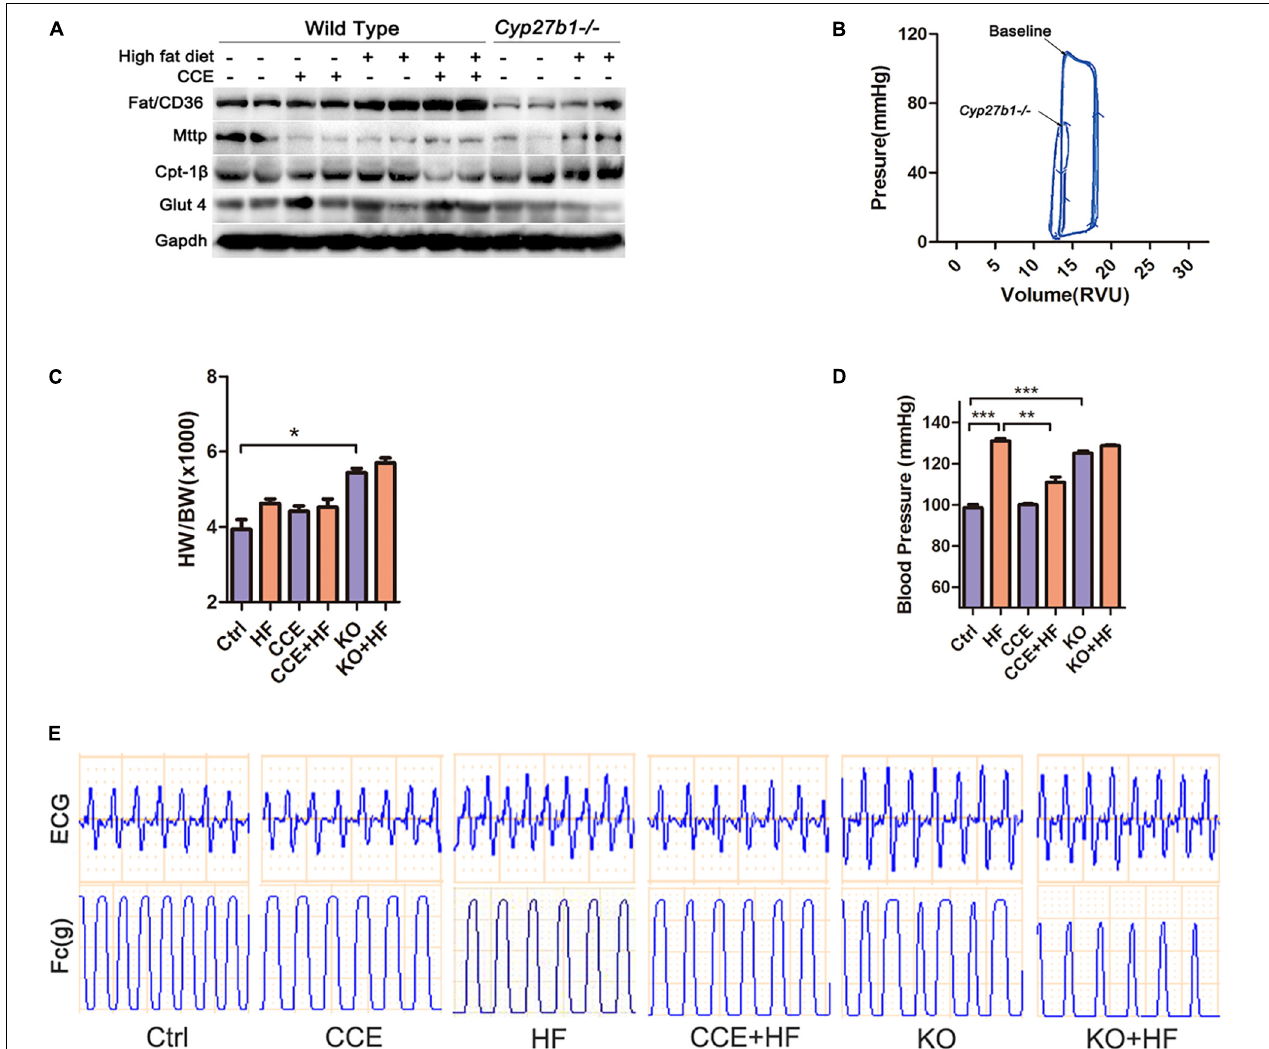
FIGURE 3 | Effect of vitamin D on lipid metabolism and cardiac function in vivo. (A) Western blot of lipid metabolism-associated proteins. (B) The left ventricular pressure-volume loop analysis revealed that heart contractility of Cyp27b1 − / − mice was lower than the baseline. (C) Heart weight normalized to mouse body weight in animals fed a high-fat diet with or without CCE. (D) Invasive blood pressure measured via the carotid artery was lower in the CCE + HF group than the HF group (* p < 0.05, ** p < 0.01, *** p < 0.001). (E) The curves of ECG and myocardial contractility were recorded for each group. Ctrl, control group. CCE, Fed cholecalciferol cholesterol emulsion [a precursor of 1, 25(OH)2D3] group. HF, Fed high fat die group. CCE + HF, Fed cholecalciferol cholesterol emulsion [a precursor of 1, 25(OH)2D3] and high fat die group. KO, Cyp27b1 − / − mice. KO + HF, Cyp27b1 − / − mice fed with high fat die